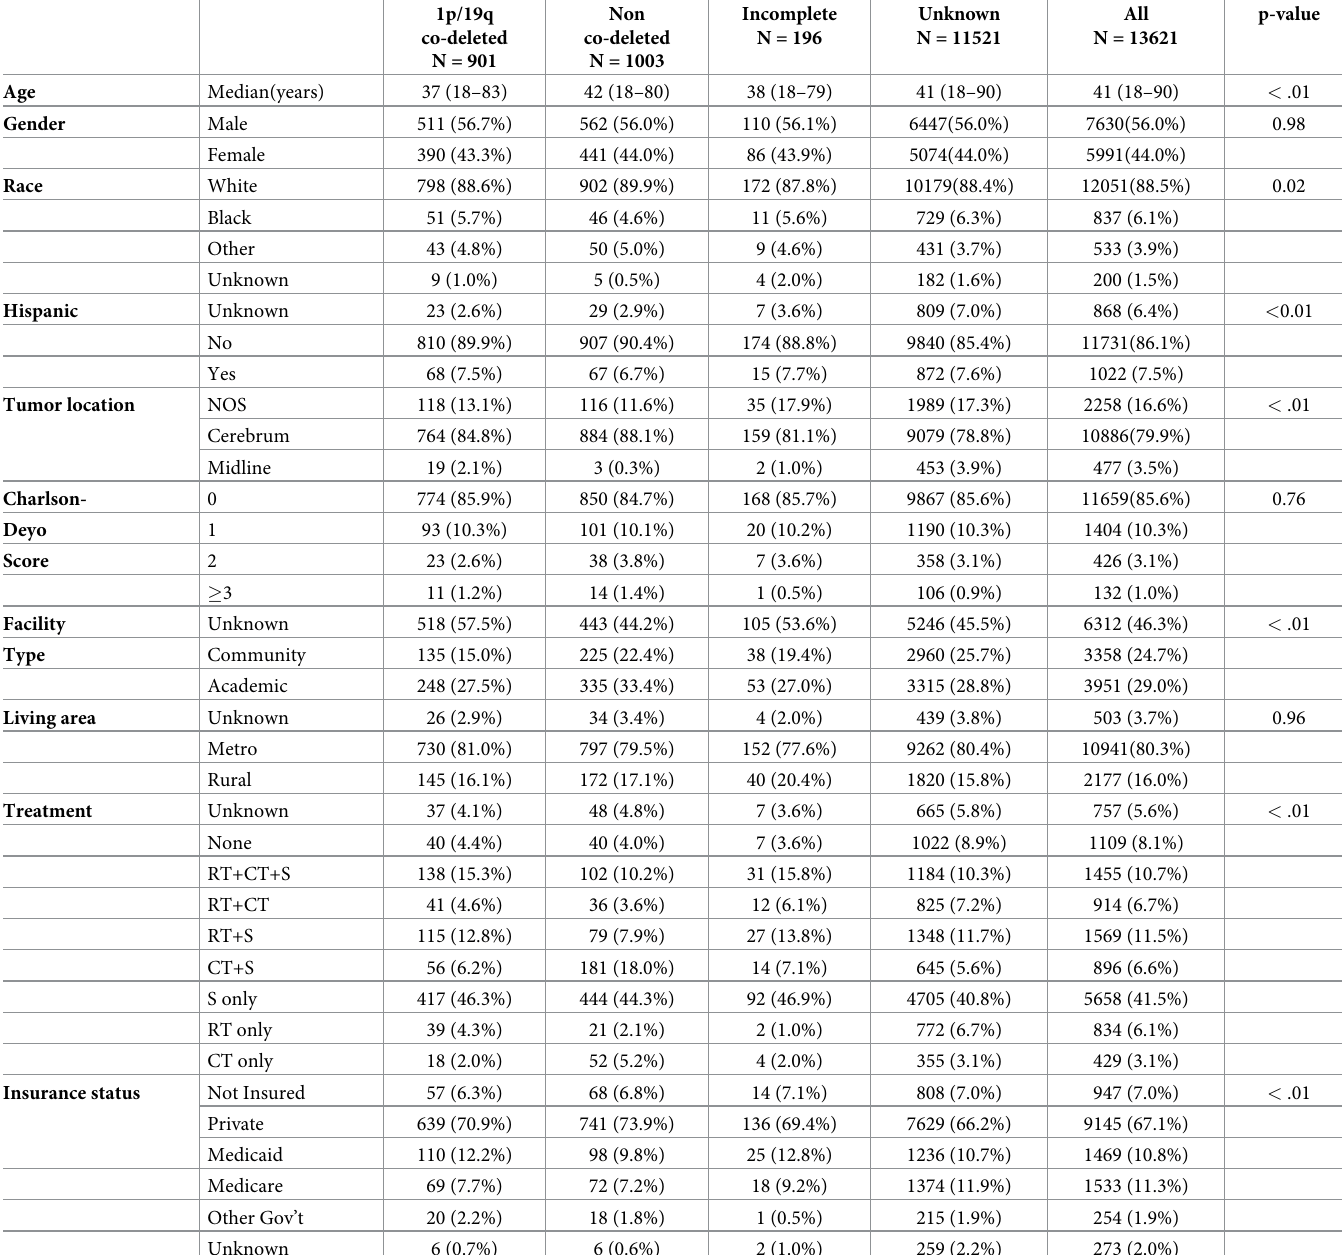
Table 3. Characteristics of the study population, by 1p/19q co-deletion